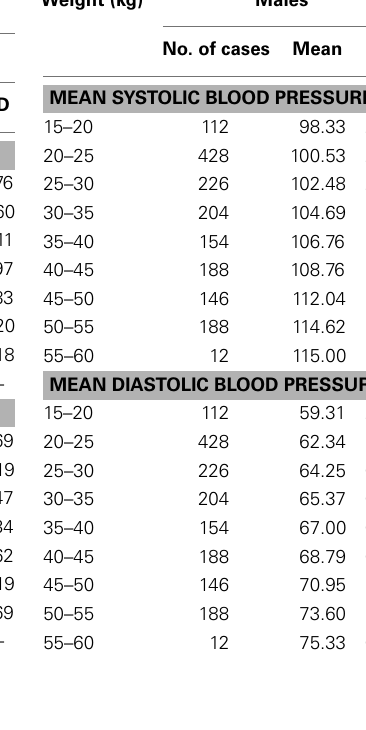
Table 2 | Relation of mean systolic blood pressure and mean diastolic blood pressure to height